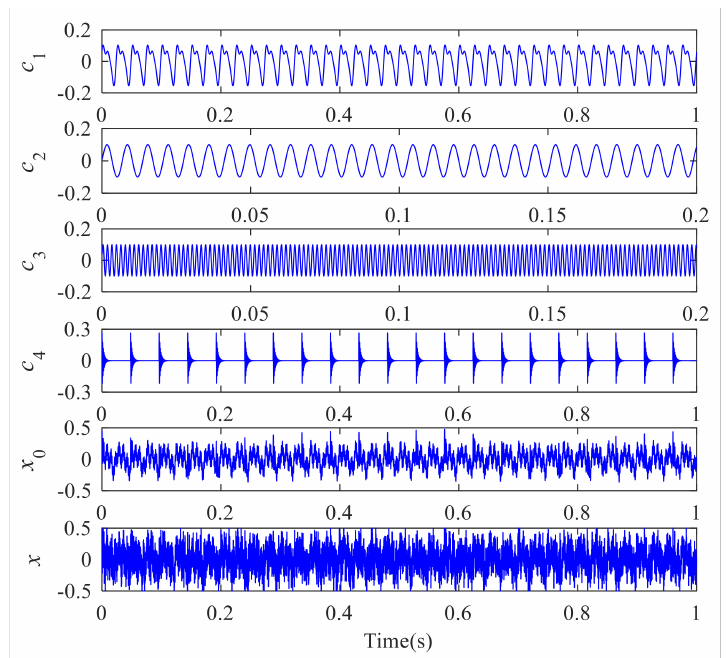
Figure 3. The final constructed simulation signal and its